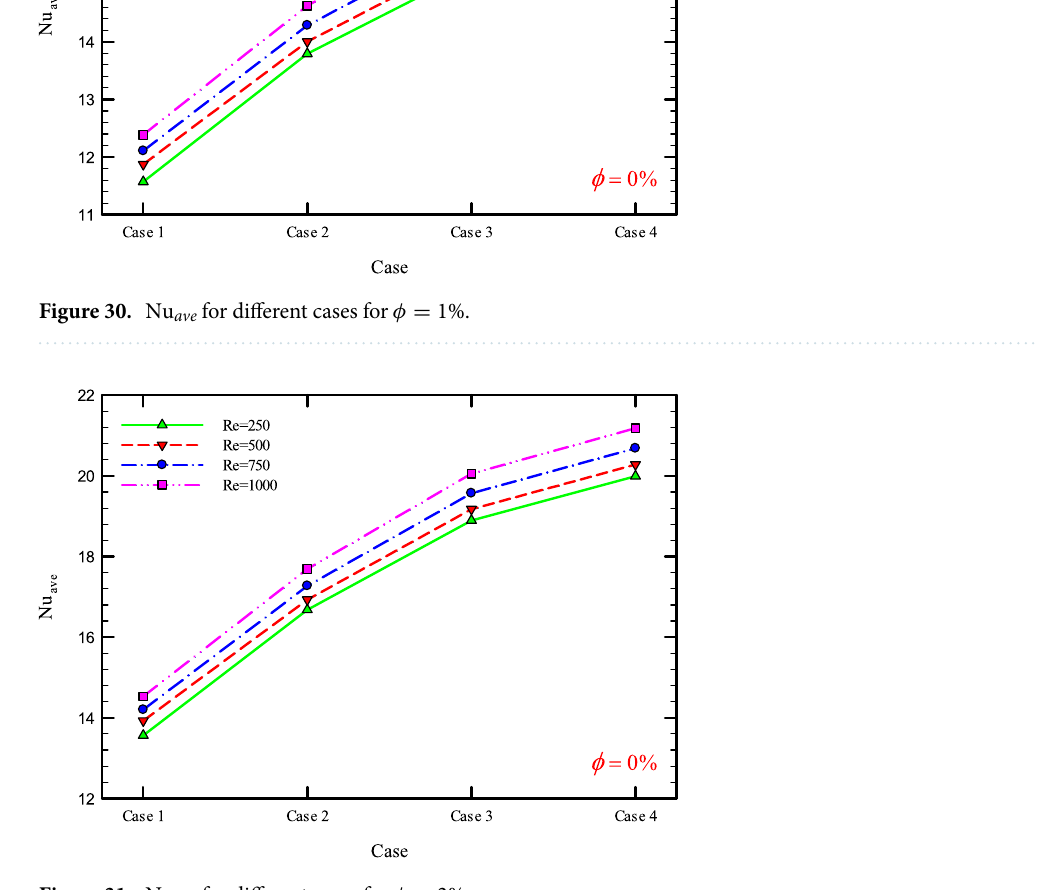
Figure 31. Nu ave for different cases for φ =